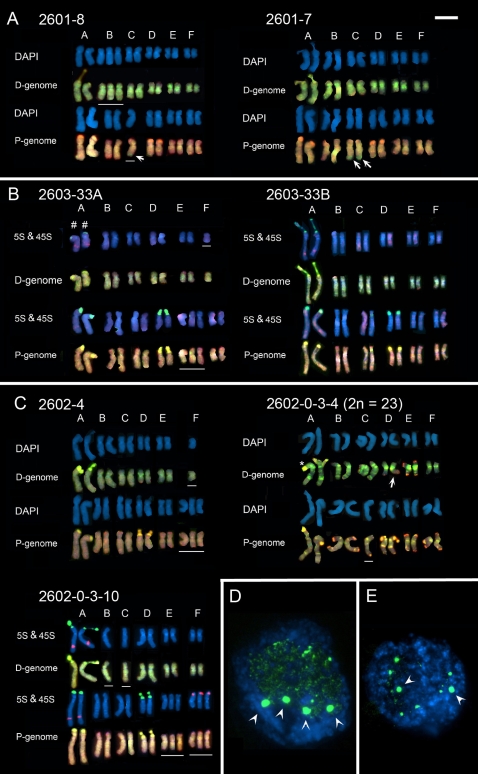
(A-C) Karyotype analyses of T. mirus from individuals in three populations (A) 2601, (B) 2603 and (C) 2602.Homeologous chromosome group nomenclature (A-F) follows Ownbey and McCollum [25] and Pires et al.
[24]. Fluorochrome colours: yellow/green (FITC, digoxigenin-labelled probes), orange/red (Cy3, biotin-labelled probes), blue (DAPI staining). Each karyotype is shown with DAPI staining, sometimes also simultaneously labelled for 45S rDNA (yellow fluorescence) or 5S rDNA (red fluorescence), and after GISH with T. dubius (green fluorescence) and T. porrifolius (red fluorescence) total genomic DNA probes. Monosomic or trisomic chromosomes are underlined. Note: (1) intergenomic translocations to chromosome Cpo/du (arrows) in individuals 2601-7 and 2601-8 and Ddu/po in individual 2602-0-3-4 (A). (2) The 45S rDNA locus on the two homologues of chromosome Adu in individuals 2602-4 and 2602-0-3-4 show different levels of decondensation, one being condensed and the other with a secondary constriction (C). (3) A large reduction in size of the 45S rDNA locus on chromosome Adu of individual 2603-33A (#) compared with other individuals (D). (4) No secondary constrictions of 45S rDNA loci on T. porrifolius origin chromosomes (Apo, Dpo) in individual 2603-33B. (D-E) Root-tip interphase nuclei of T. mirus after FISH with digoxigenin-labelled pTa71 for 45S rDNA. (D) Individual 2601-4, showing four large condensed 45S rDNA loci (arrows) and (E) Individual 2602-0-3-10 with two large condensed 45S rDNA loci (arrows). Scale bar (top right) is 10 µm.